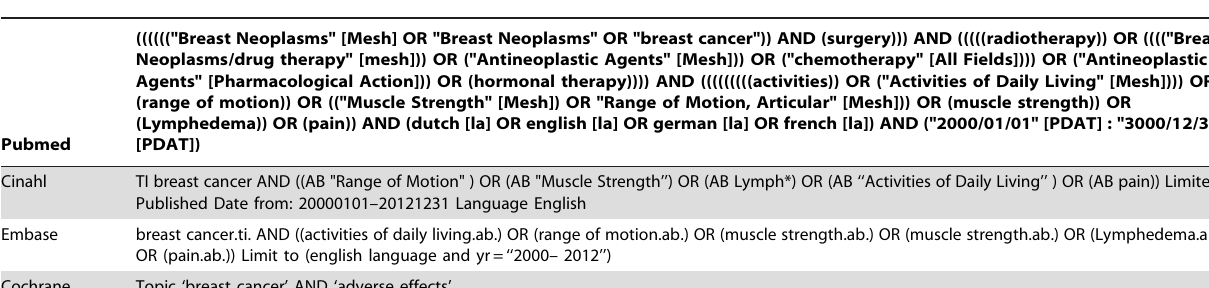
Table 1. Search string adverse